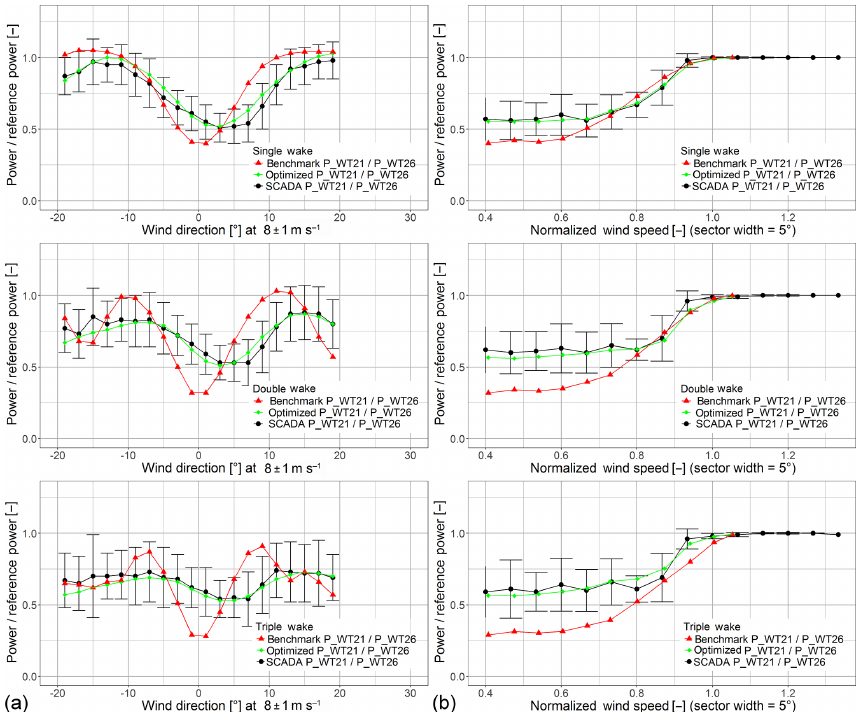
Figure 9. Tuning of the wake model results. (a) Power normalized by the power of the free-flow turbine as a function of the wind direction centered at full wake for 8 ± 1ms − 1 wind speed. (b) Power normalized by the power of the free-flow turbine as a function of the wind speed normalized by wind speed at rated power for the waked turbine. Black dots represent the measured and binned SCADA data with error bars of 1 standard deviation. The red triangles show wake model results with Fuga standard settings ( ζ 0 = 0, no Gaussian averaging), and the green diamonds provide the tuned results. ( ζ 0 = 2 . 72 × 10 − 7 , Gaussian averaging as a function of the wind speed and applying the wind direction offset to account for the wake